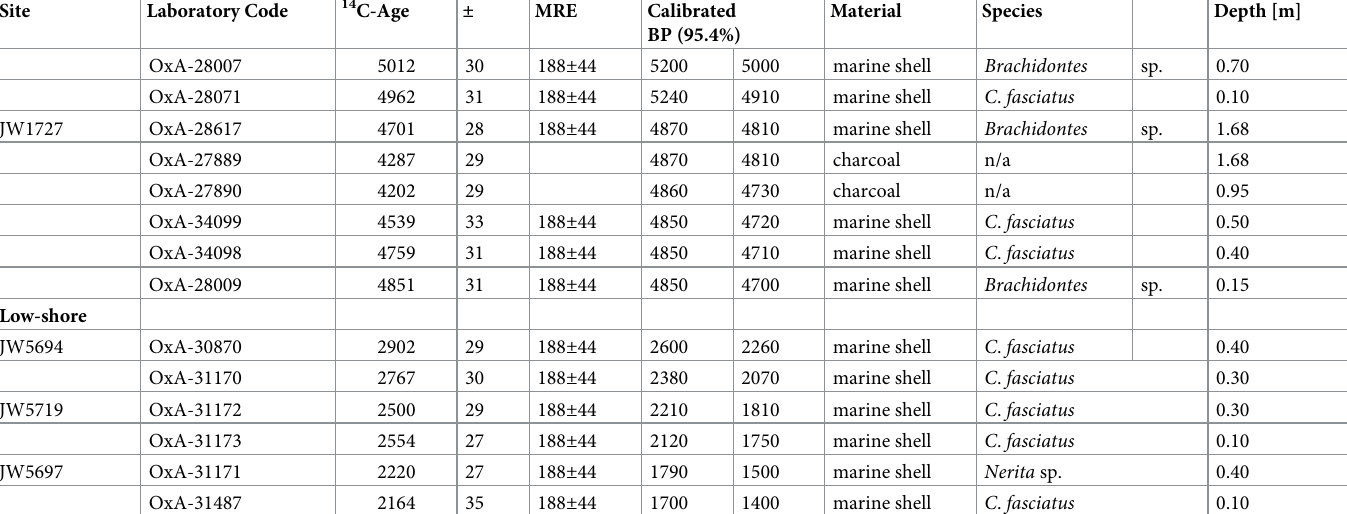
The rates of accumulation of shoreline and post-shore sites are distinctly different (Table 2; Fig 11). Shoreline sites show a range of accumulation rates of 0.24–1.29 m/ka (mean = 0.66 m/ ka), while the range at processing sites is 0.11–17.39 m/ka (mean = 4.19 m/ka). The rate at pro- cessing sites is higher still– 5.87 m/ka if we exclude the youngest sites from the lower shorelines and include only those sites that fall within the main period of shellfish exploitation (i.e.